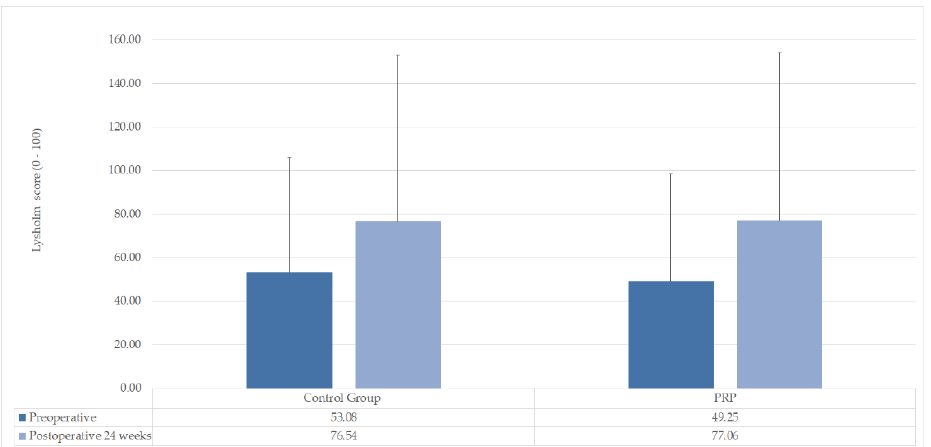
Figure 6. Preoperative vs postoperative pain WOMAC scores.